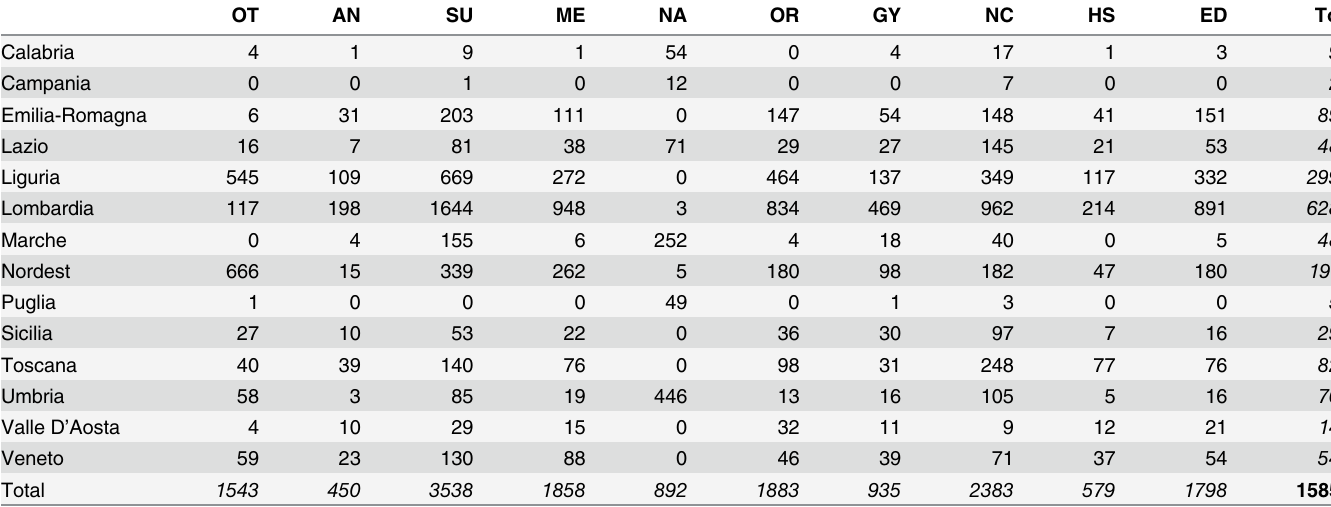
Table 3. Number of claims by department (columns) and geographic region (rows), as used in the analysis of the monetary